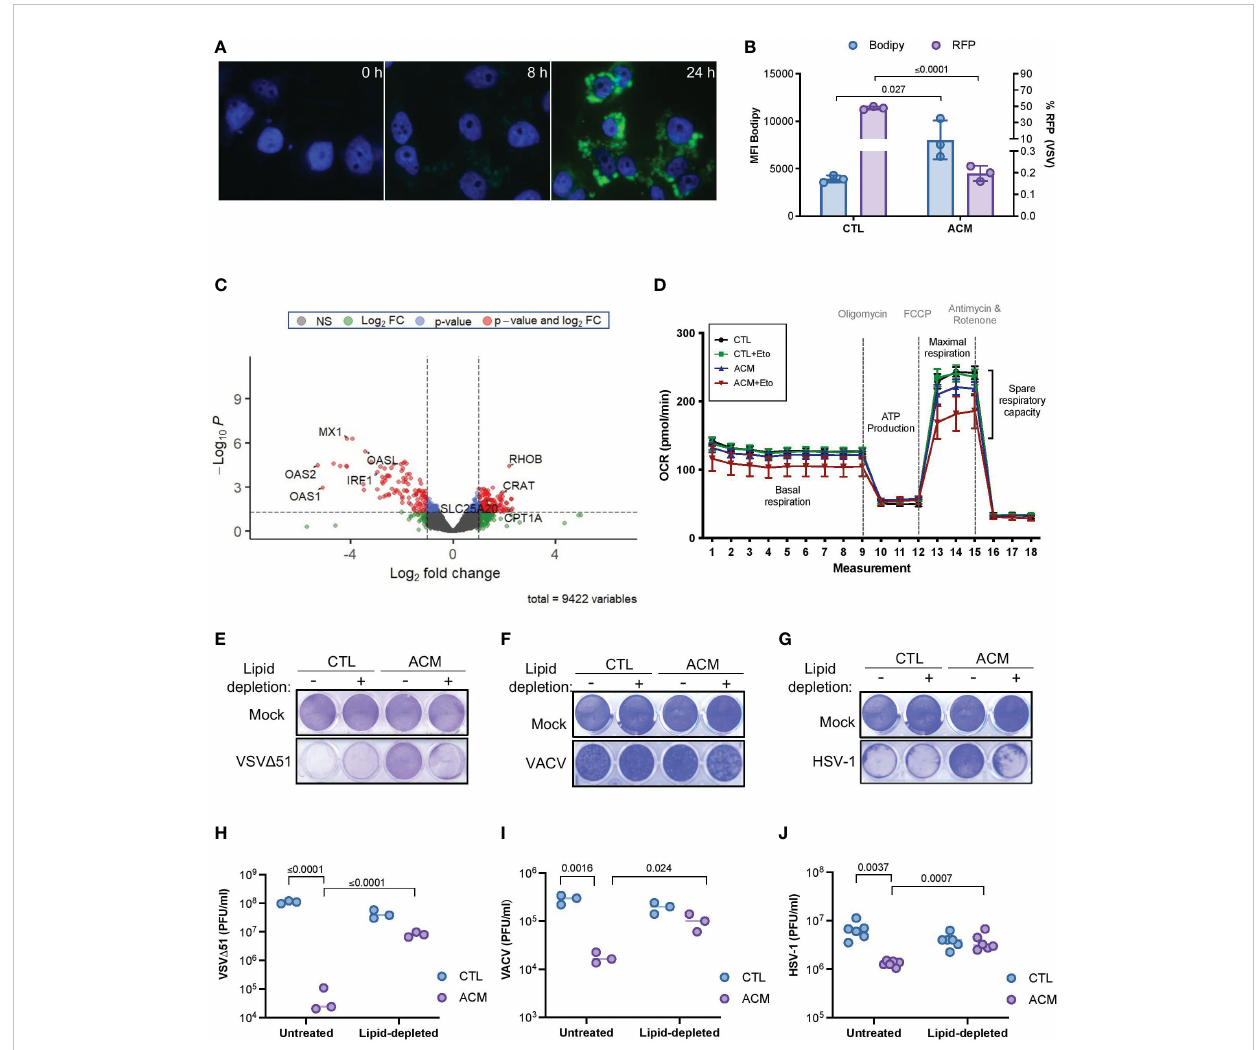
FIGURE 3 Adipocyte-derived lipid moieties are the key drivers of OV resistance. (A) OVCAR8 cells cultured in ACM for the indicated lengths of time and stained with Bodipy to label neutral lipid content. DAPI denotes nuclei staining. (B) SKOV3 cells were infected with an RFP-expressing VSV D 51 (MOI 3, 18 hours) and stained with Bodipy for fl ow cytometry analysis. Data indicate the mean ± SEM of 3 biological replicates. Two-tailed, unpaired t-test. (C) OVCAR8 cells were cultured in ACM or CTL-medium for 18 hours prior to harvesting total RNA for RNA sequencing analysis. The data was analyzed relative to ACM to visualize the relative changes of gene expression in ACM from two biological replicates. Y-axis dotted line denotes a p- value cut-off of 0.05. X-axis dotted lines denote a 2-fold change cut off. (D) Oxygen consumption rate (OCR) in OVCAR8 cells cultured in a